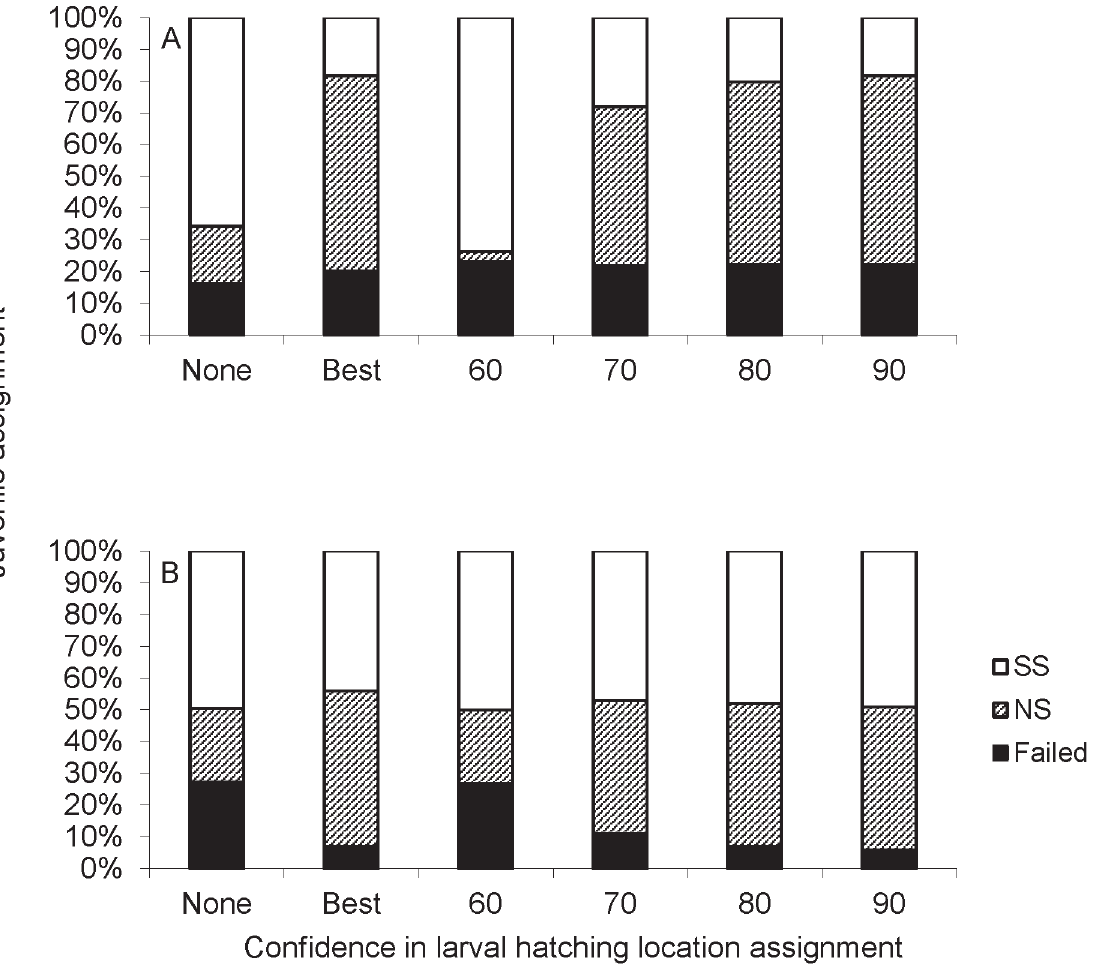
Fig 5. Predicted origins of juvenile yellow perch collected in open waters of western Lake Erie using otolith microchemistry from larvae collected in north-shore (NS) and south-shore (SS) water during a) 2006 and b) 2007. A total of N = 98 juveniles were analyzed each year. Juveniles with < 70% likelihood of originating within a population were consider “ failed ” and juveniles with a probability > 70% were assigned to NS or SS. Certainty in hatching locations of larvae used to develop classification functions was as follows: None = null assignments based on capture location (i.e., no backtracking used); Best = larvae assigned to single most likely hatching location (SS or NS) based on backtracking; and 60, 70, 80, 90 = larvae assigned to hatching location after backtracking revision with 60, 70, 80, 90% levels of certainty in hatching origin,